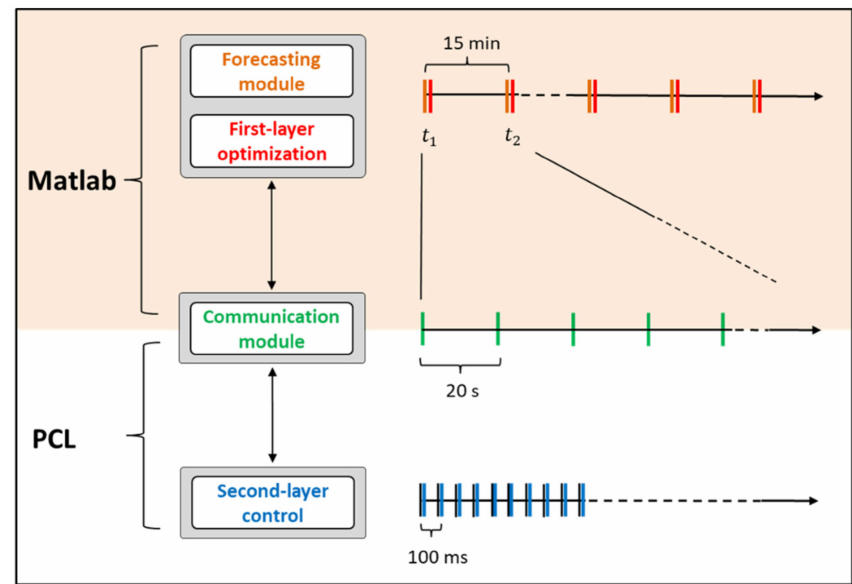
Figure 6. EMS implementation structure.